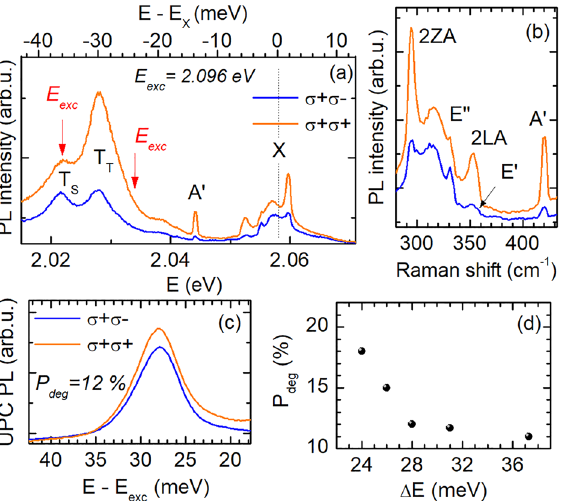
Figure 6. ( a ) Circularly polarized PL spectra for quasi-resonant exciton excitation at 2.096 eV. ( b ) Helicity- resolved Raman scattering spectra excited at 2.096 eV. ( c ) Co- and cross-polarized UPC PL spectra at 7 K, showing an enhancement in the exciton emission at about 28 meV below the X resonance. ( d ) Evolution of P deg as function of the energy gain (cid:31) E